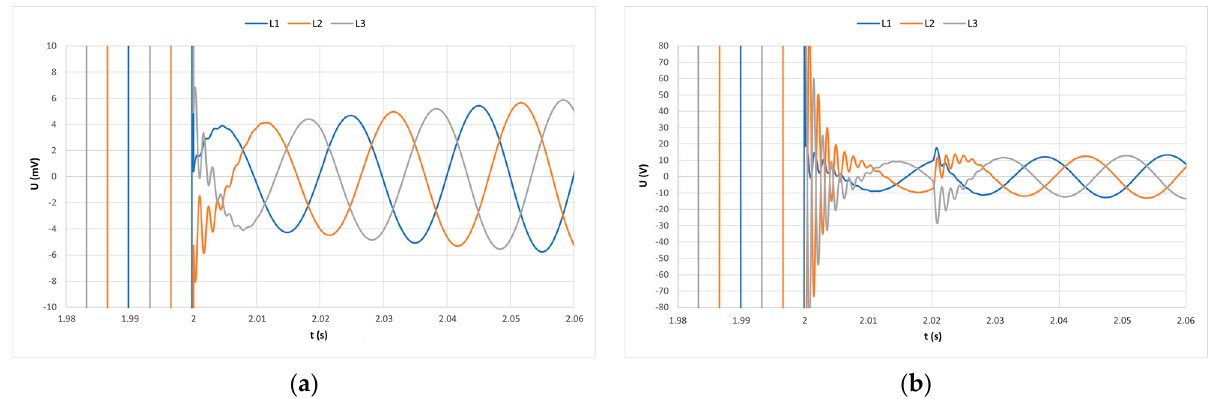
Figure 20. Simulated values of battery energy storage system model currents during a 3-Ph ground fault condition at the source.